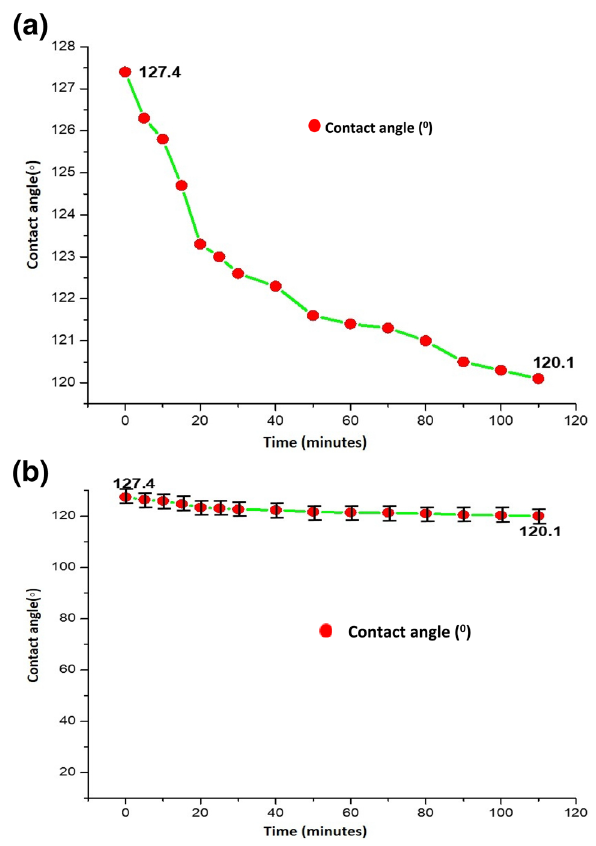
Fig. 14 a , b Analysis the contact angle by changing of time in dif- ferent scale